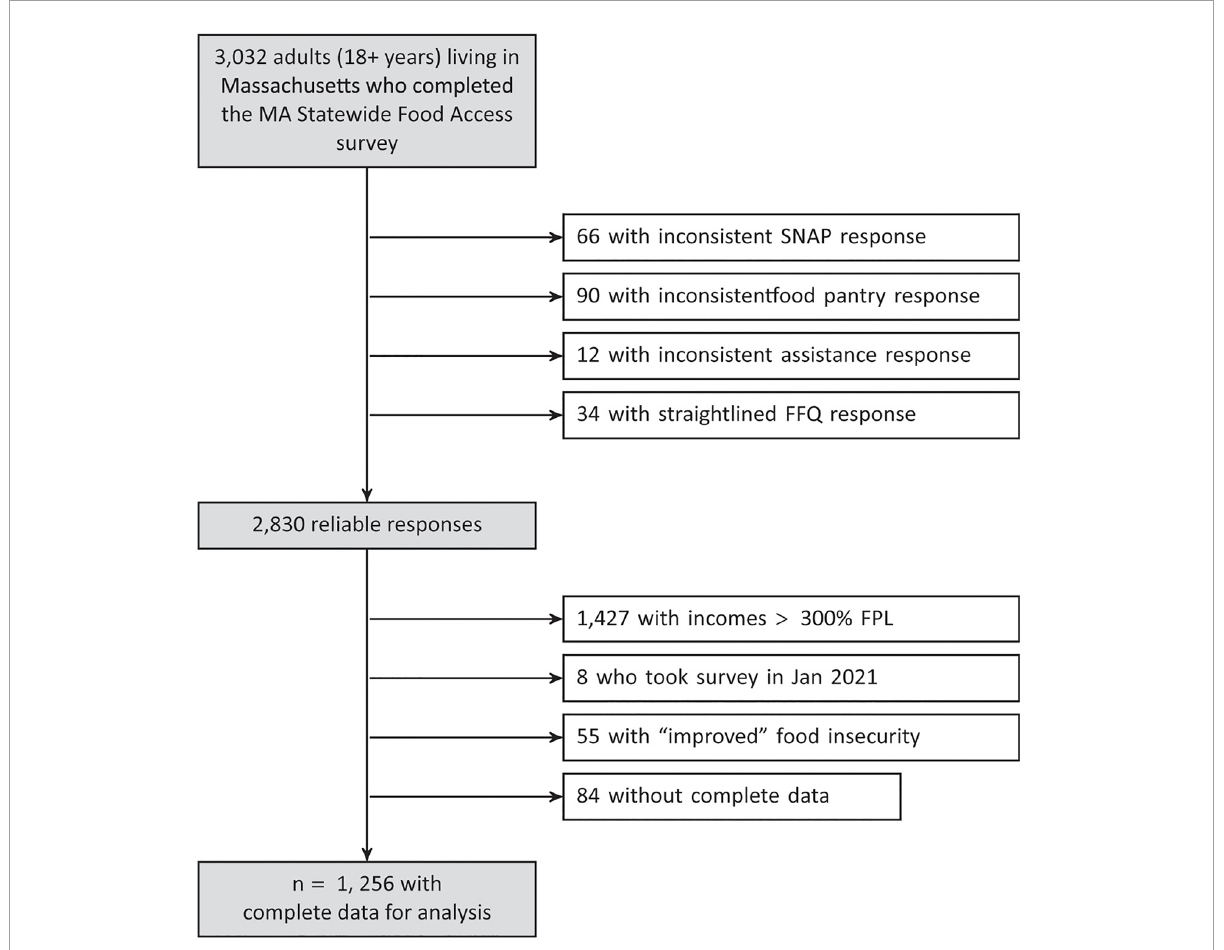
FIGURE1 Participant flow diagram. FFQ, food frequency questionnaire; FPL, federal poverty level; GBFB, The Greater Boston Food Bank; MA, Massachusetts; NFACT, National Food Access and COVID Research Team; SNAP, Supplemental Nutrition Assistance